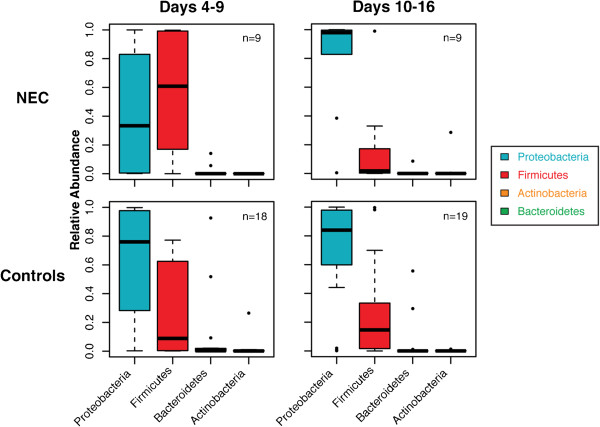
The relative abundance of bacterial phyla in infants who developed NEC vs control infants. Columns represent samples from days of life for 4 to 9 and 10 to 16. Data are graphed as box plots. The middle bar represents the median, the outer horizontal lines of the box represent the 25th and 75th percentiles. Dots above or below each box indicate outliers. NEC: necrotizing enterocolitis.